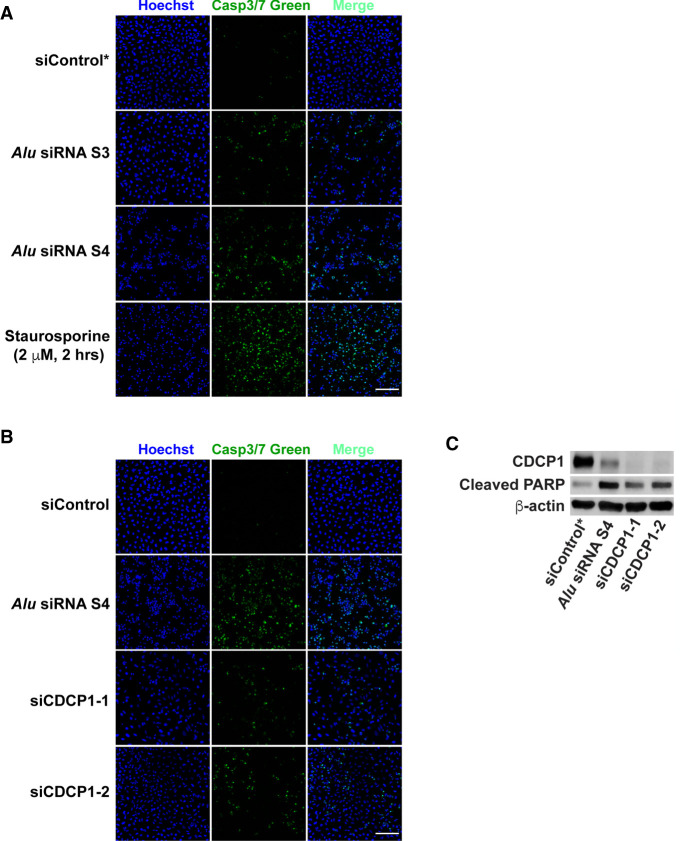
Alu siRNAs induce apoptosis. (A) Fluorescence microscopic detection of apoptosis induced in Alu siRNA-transfected HeLa cells in comparison to the cells treated with a known inducer of apoptosis, Staurosporine (2 µM, 2 h). Apoptosis was evaluated with the CellEvent Caspase-3/7 Green apoptosis-detection system (Life Technologies). (B) Apoptosis induced in CDCP1 knockdown HeLa cells was also evaluated using the CellEvent Caspase-3/7 Green apoptosis-detection system. Scale bars, 200 µm. (C) The extent of apoptosis induced by Alu siRNA transfection or CDCP1 knockdown was analyzed by western blotting of cleaved poly(ADP-ribose) polymerase (PARP). CDCP1 bands represent the full-length protein (135 kDa), whereas PARP bands represent the cleaved protein (89 kDa).